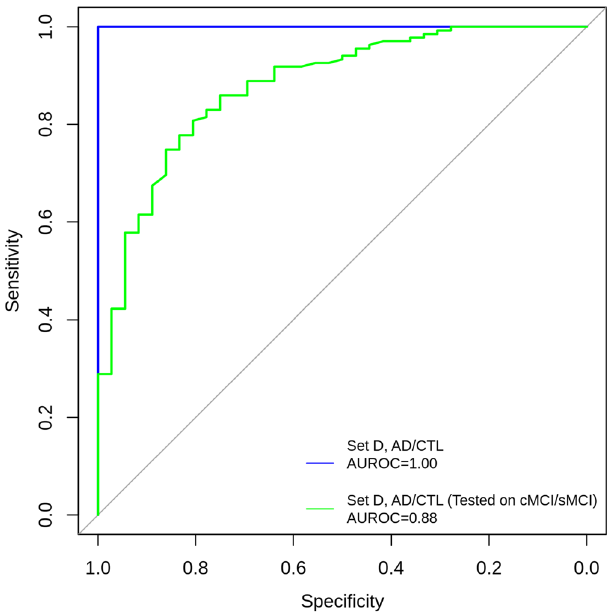
Figure 3. Receiver Operating Characteristic (ROC) curves for RF model discriminating AD vs CTL and then applied to cMCI and sMCI study groups. The model was trained with 1542 prioritised metabolic features and three covariates (age, sex, study site) identified from the AD vs CTL comparison only. The area under the ROC curve (AUROC) value for the AD vs CTL is 0.99. The AUROC value for cMCI vs sMCI classes is 0.88.